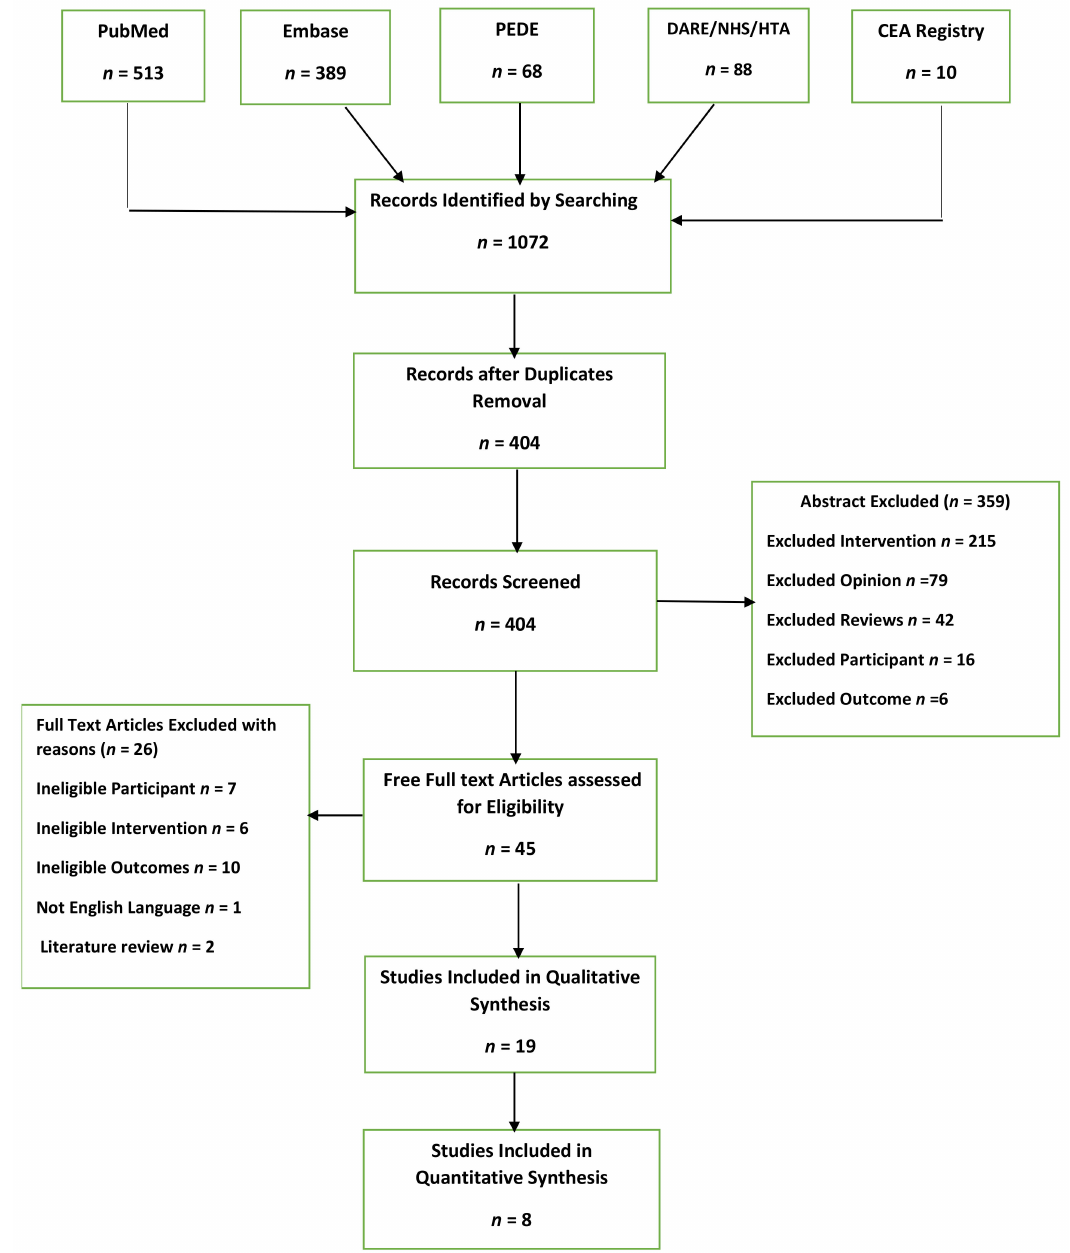
Figure 1. Preferred Reporting Items for Systematic Reviews and Meta-Analysis (PRISMA) flow diagram for the inclusion of